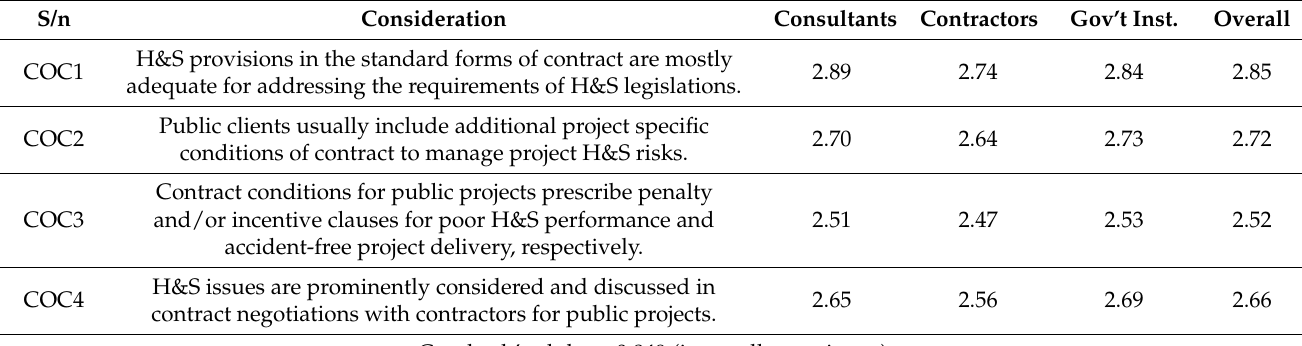
Table 11. H&S considerations in conditions of